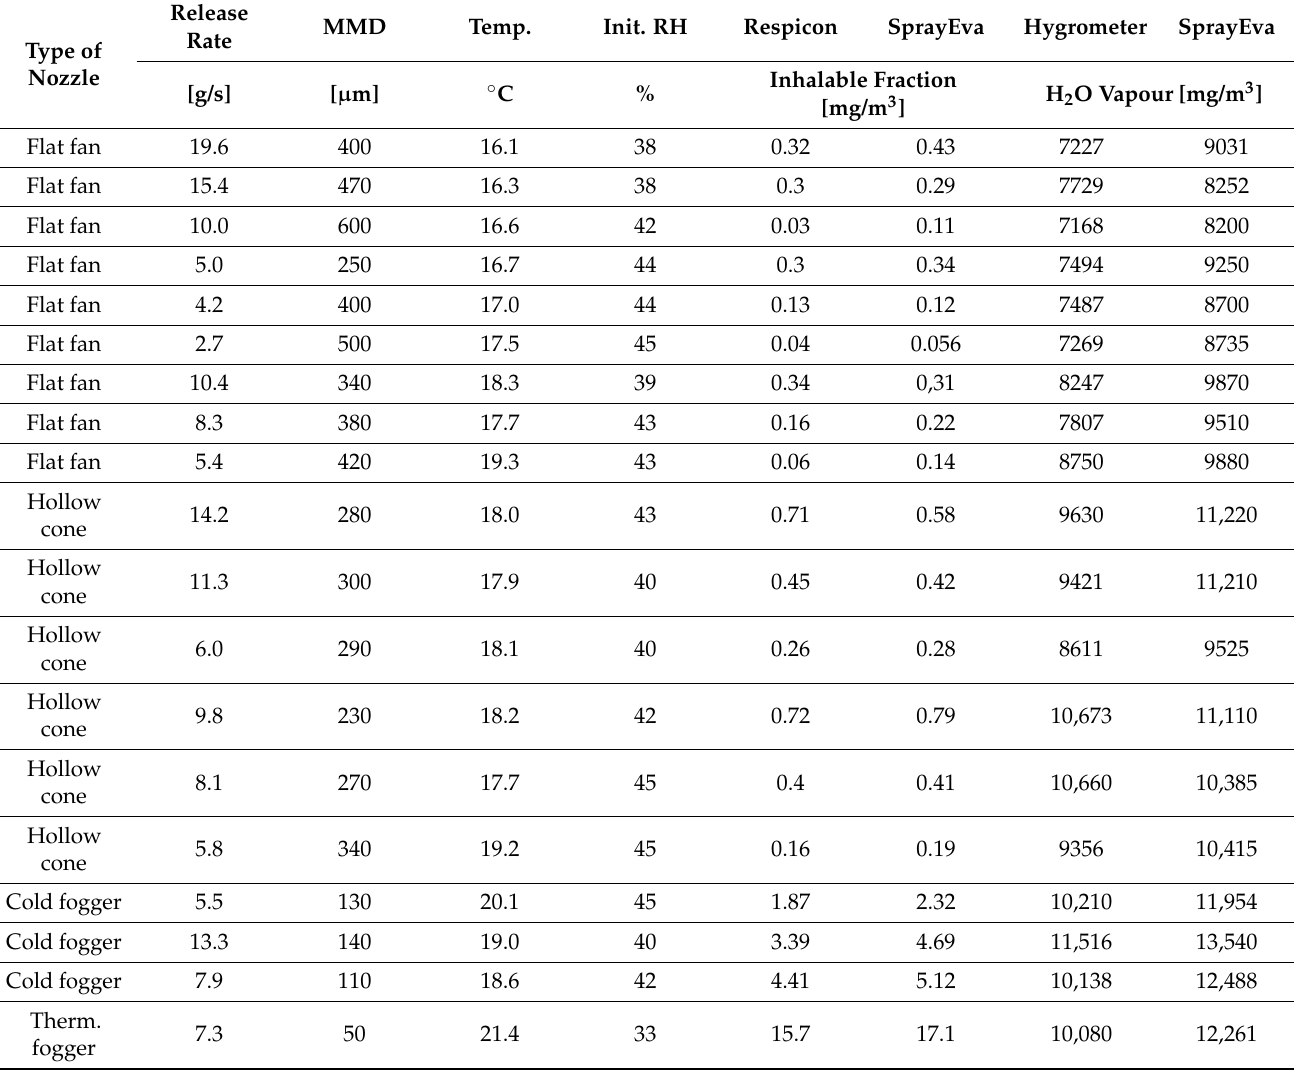
Table 4. Input parameters and measured values vs. model